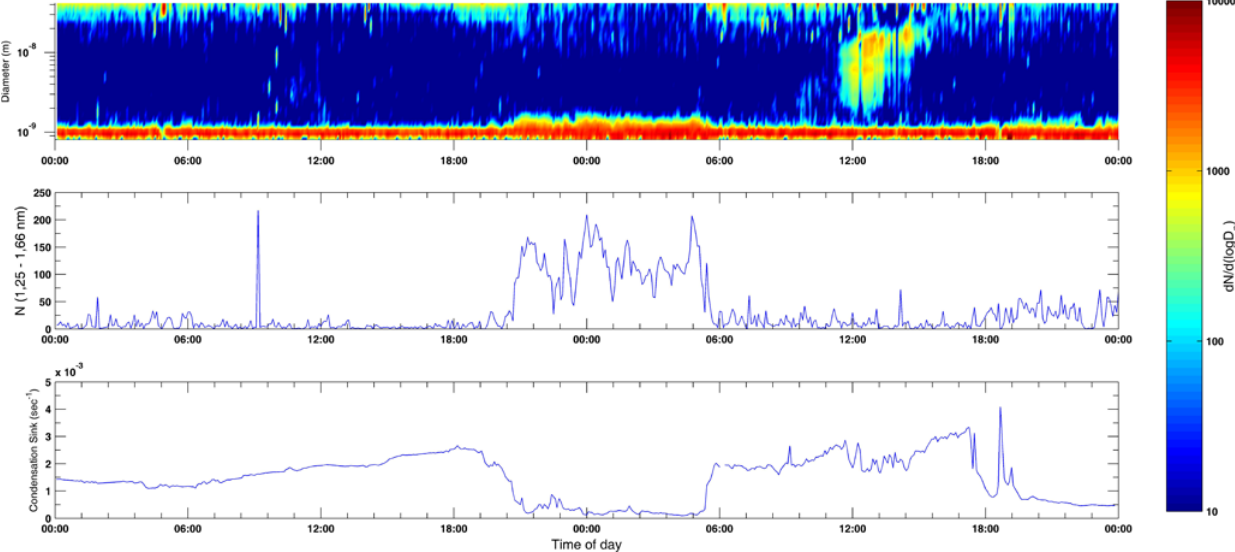
Fig. 9. Night-time enhanced ion concentration event observed on 29–30 March 2009 demonstrating a clear case of anti-correlation of small ion cluster concentrations with CoagS. Upper panel: negative ion number size distribution. Middle panel: negative ion number concentration in the size range 1.25–1.66nm. Lower panel: 2nm CoagS. Time of the day in UTC.